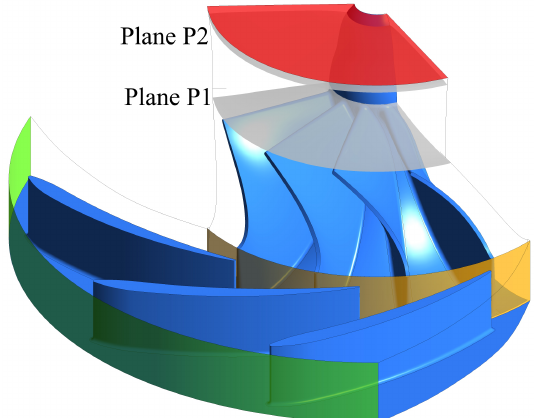
Figure 3. Computational domain with inlet (green), interface (orange), outlet (red) and analysis planes